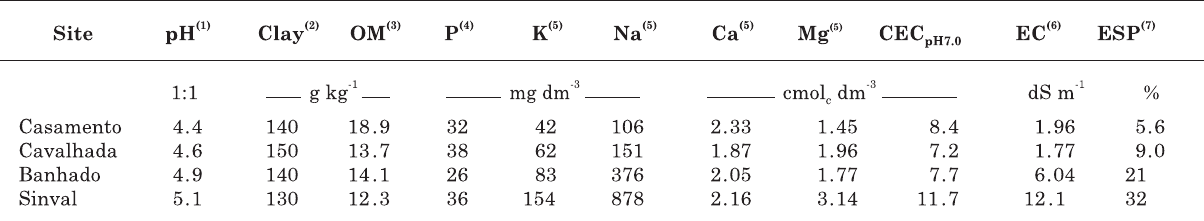
(1) pH in H O (Tedesco et al., 1995). (2) Pipette method (Tedesco et al., 1995). (3) Soil organic matter, wet combustion method 2 (Tedesco et al., 1995). (4) Mehlich 1 (Tedesco et al., 1995). (5) Ammonium acetate extractant, 1,0 mol L -1 (Embrapa, 1997). (6)